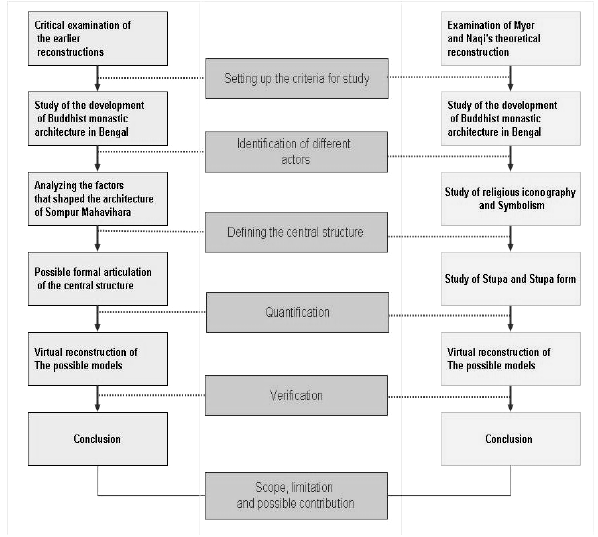
Fig.2: A comparison between the initial research outline and actual course of study (Rashid, Hafiz,